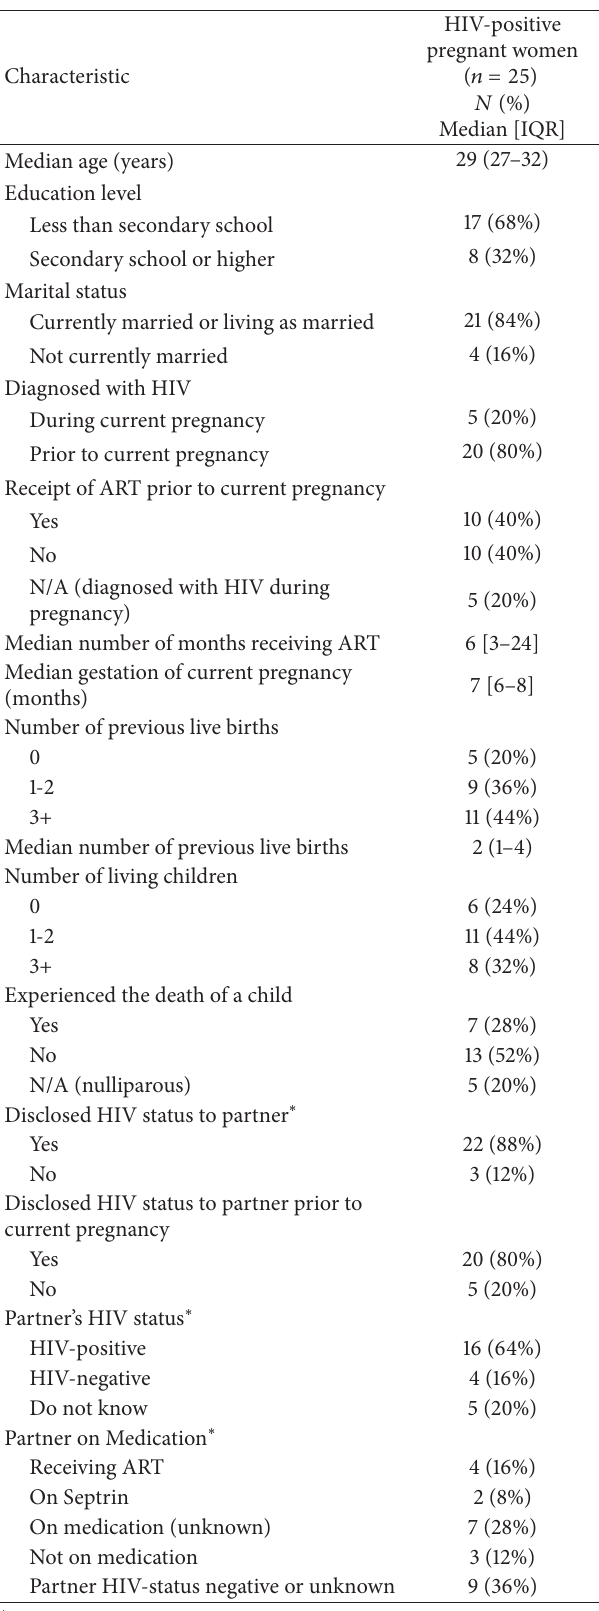
Table 1: Characteristics of study